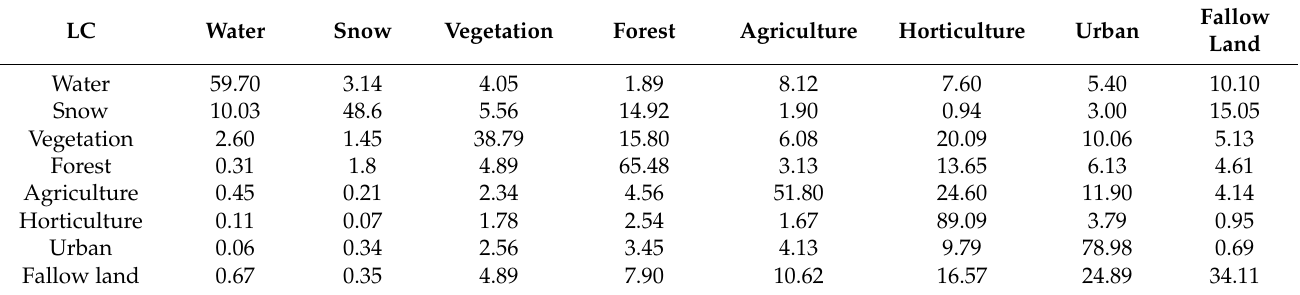
Table 8. Transfer Probability matrix during 2000–2010 (km 2 ).